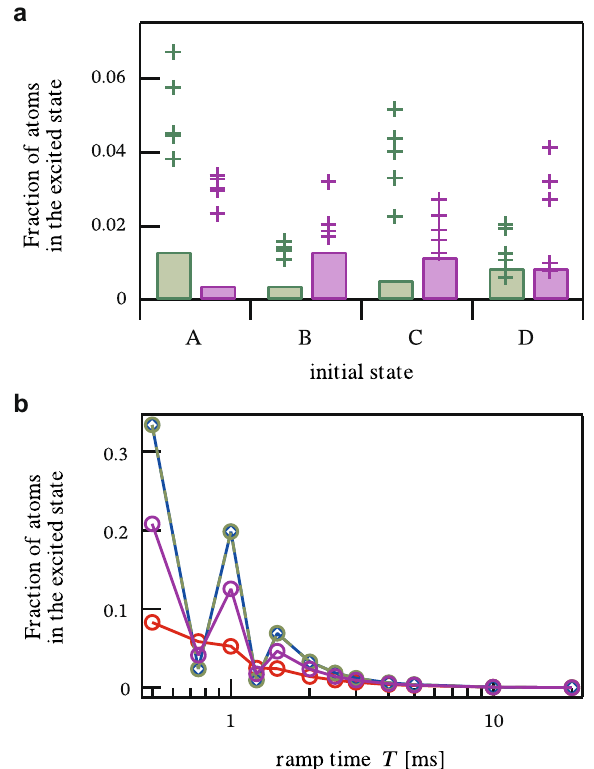
Fig. 6 Excited-state population after the W.-Z. phase acquisition. a Experimentally and numerically obtained excited state population at T = 2 ms for θ 2 = 11 π /36. Experimental data for the paths C þ (green points) and C (cid:3) (purple points) compared with numerical simulation for the paths C þ (green bar) and C (cid:3) (purple bar). b Fraction of atoms in the excited state manifold after the state acquired W.-Z. phase along C (cid:3) numerically simulated for the four initial states at θ 2 = π /4. The four states are A j i (red), B j i (blue), C j i (green), and D j i (purple). Due to fi nite ramp time T for tracing out the loop, the non-adiabatic effect is non-negligible when the ramp rate becomes comparable to the scale of the energy gap ( Δ E = h × 2